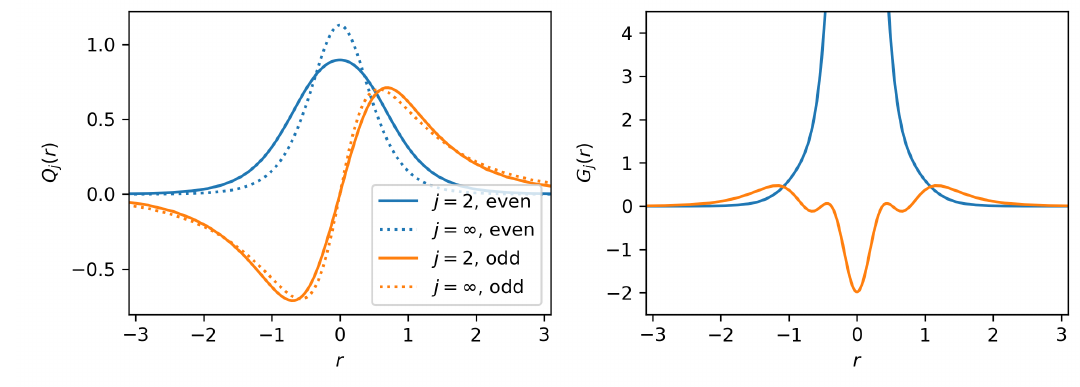
Figure 5. (Left) Even and odd bound states for j = 2 and j → ∞ . (Right) The functions G j ( r ) for the even and odd j = 2 bound states. For the even bound state the integral over G j diverges while for the odd bound state it